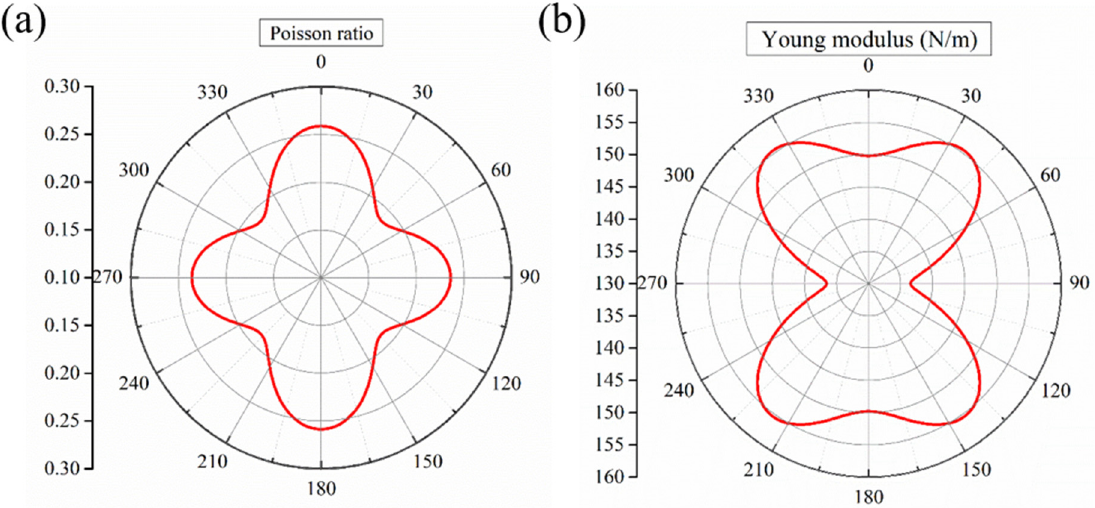
Figure 2. ( a , b ) show the Poisson’s ratio and Young’s modulus of monolayer TiNI